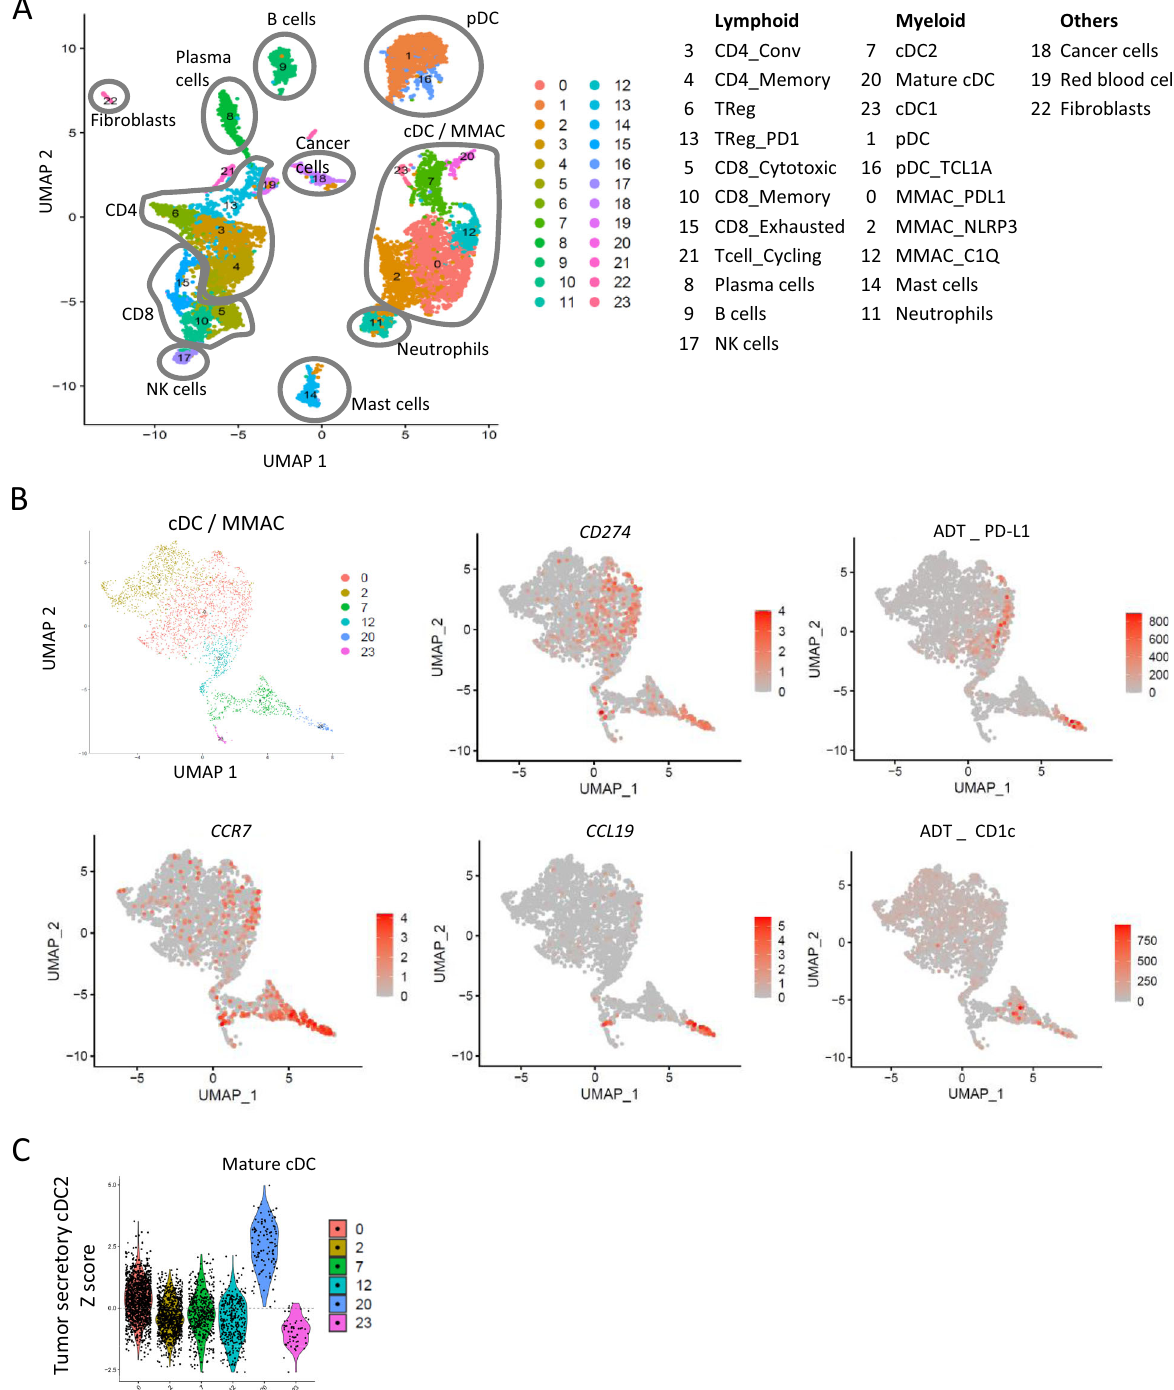
Fig. 6 Tumor secretory cDC align with the mature migratory cDC subset in HNSCC. A UMAP of the 10,503 cells analyzed by single-cell RNA sequencing displayed in 24 clusters. B, C Analysis of the 6 cDC/MMAC clusters as per 6A. B UMAP per cluster and expression of selected genes and antibody-derived tags (ADT). ADT staining was not present in all samples, see Methods for details. C Expression of the Tumor Secretory cDC2 signature. CD4 CD4 T cells, Conv conventional, TReg regulatory T cells, CD8 CD8 T cells, NK natural killer cells, pDC plasmacytoid DC, MMAC monocytes and